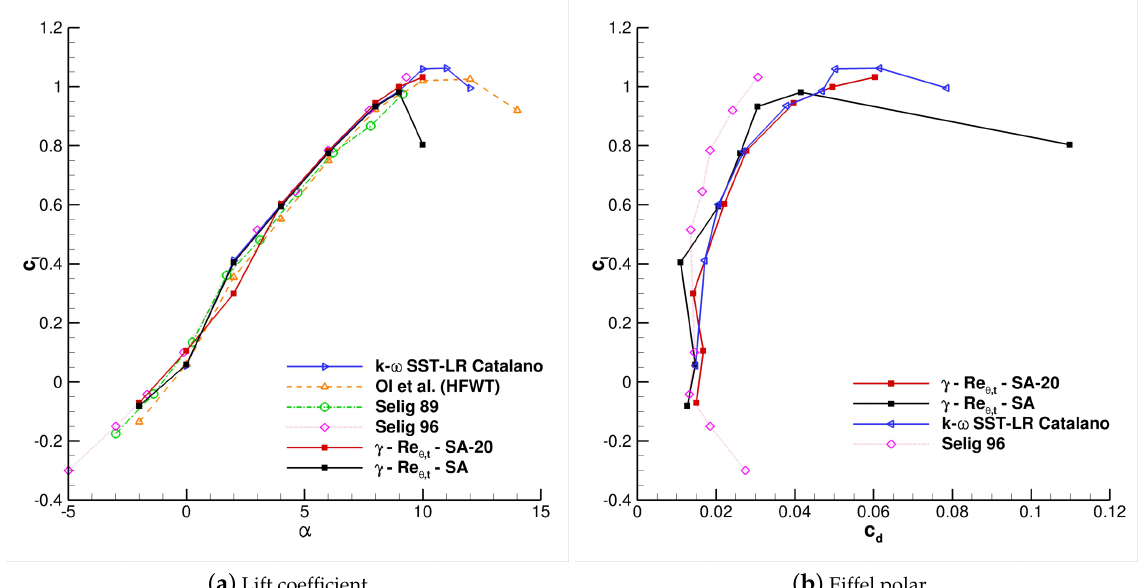
Figure 5. SD7003, Re = 6 × 10 4 . Force coefficients